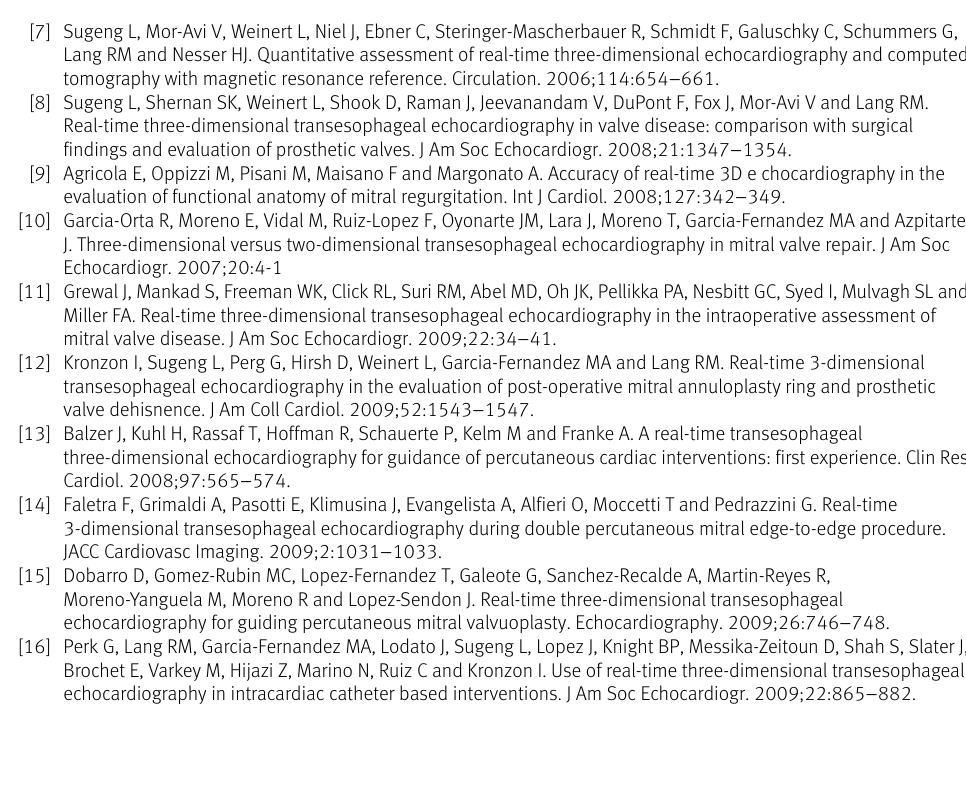
Figure. 10 3D echocardiograph image of two orifices created by E-clip in a patient who developed late failure and required valve